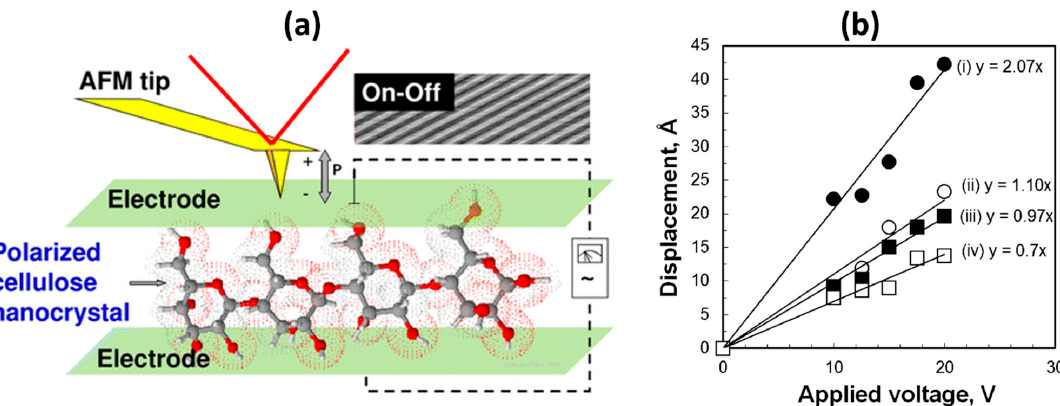
Figure 11. ( a ) Characterization of well aligned CNC ultrathin film for its dielectric property using Atomic Force Microscopy (AFM) in tapping mode and ( b ) effect of voltage on CNC displace (piezoelectric